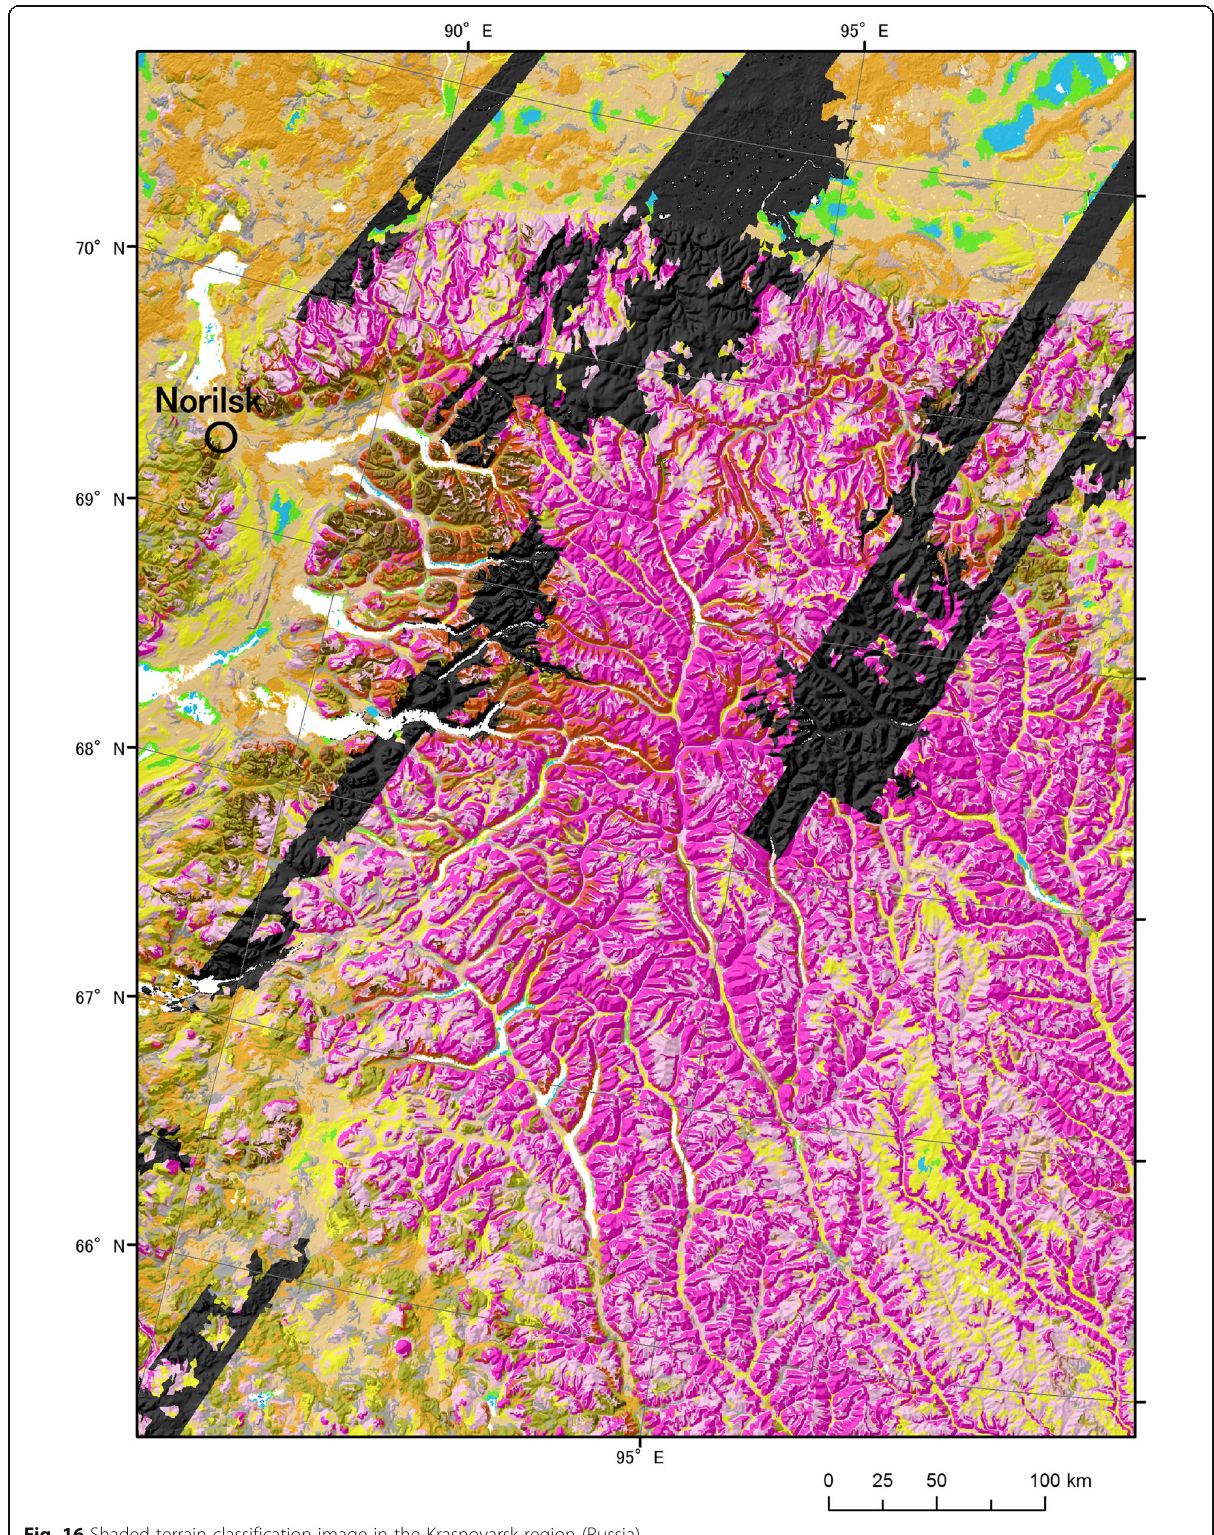
Fig. 16 Shaded terrain classification image in the Krasnoyarsk region